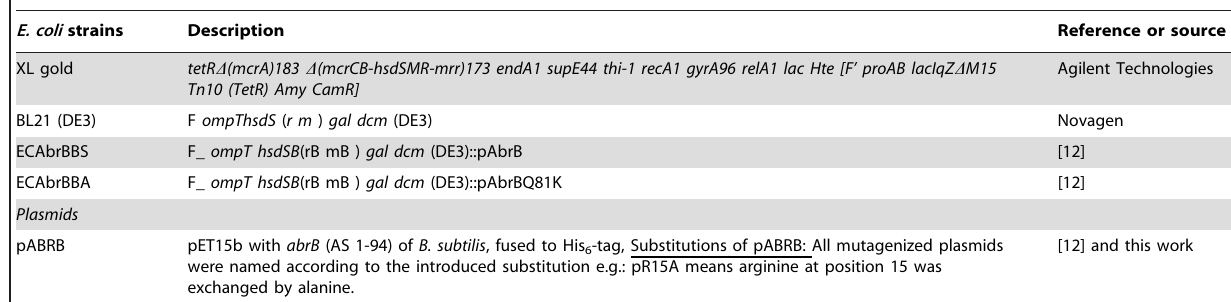
Table 1. Strains and plasmids used in this study